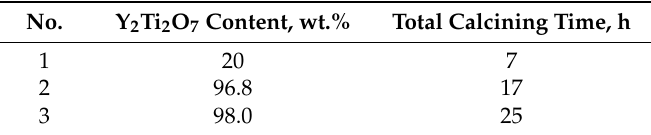
Table 1. Y 2 Ti 2 O 7 content in the samples after calcination at 1150 ◦ C for subsequent stages of 7, 10, and 8 h.